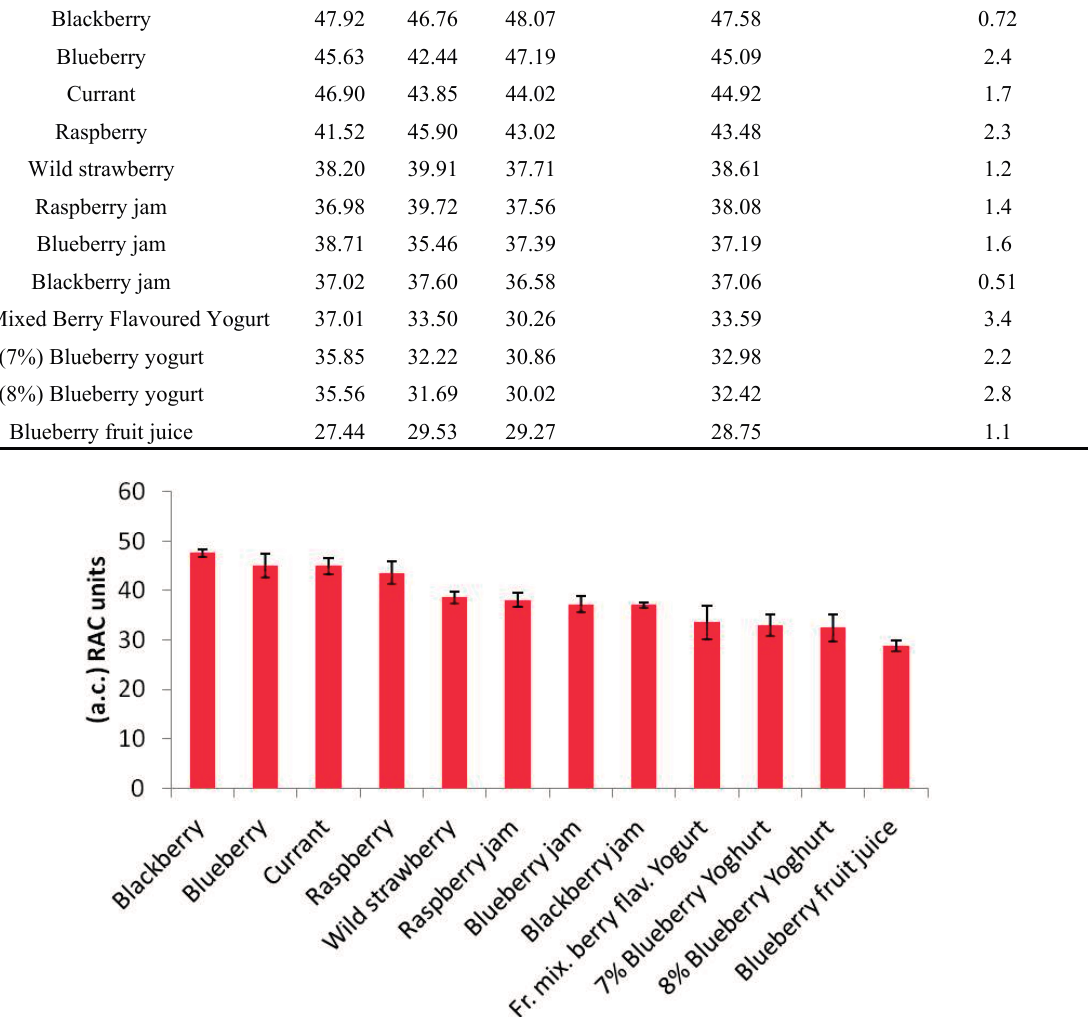
Figure 2. Histogram of antioxidant capacity values (a.c.), obtained using the biosensor method. Results expressed in RAC